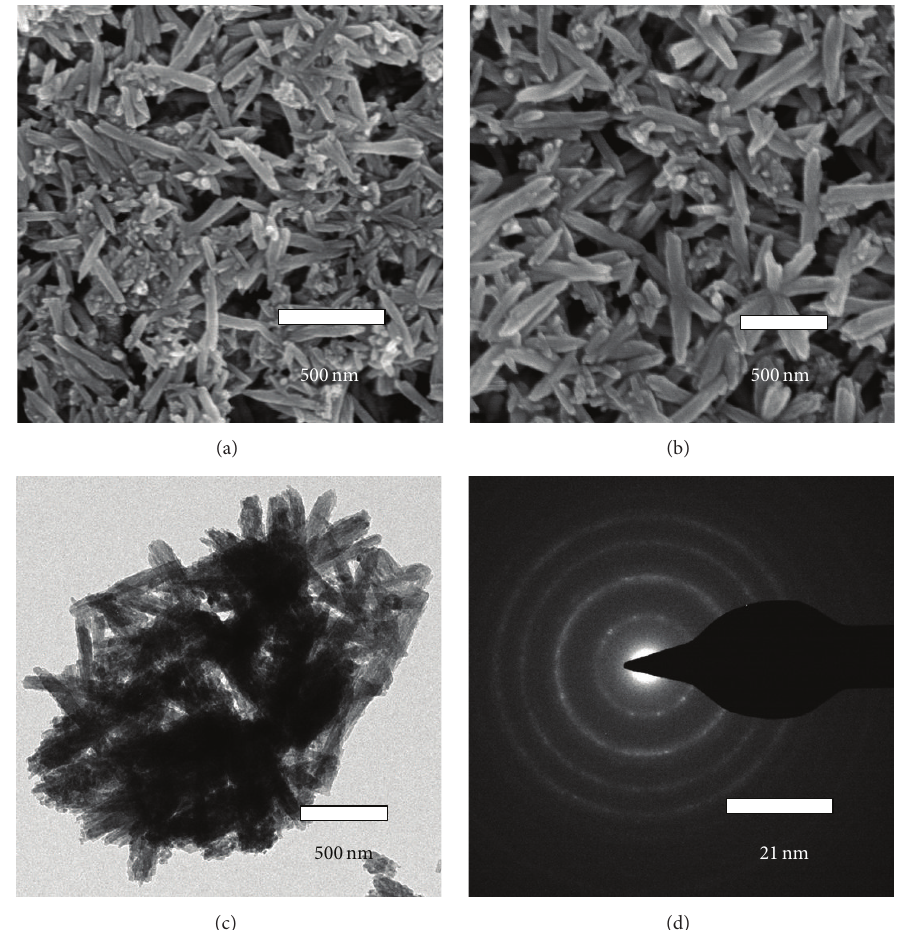
Figure 6: FESEM images of (a) pure SnO 2 and (b) Sm 2 O 3 decorated SnO 2 and TEM image (c) and SAED image (d) of Sm 2 O 3 decorated SnO 2